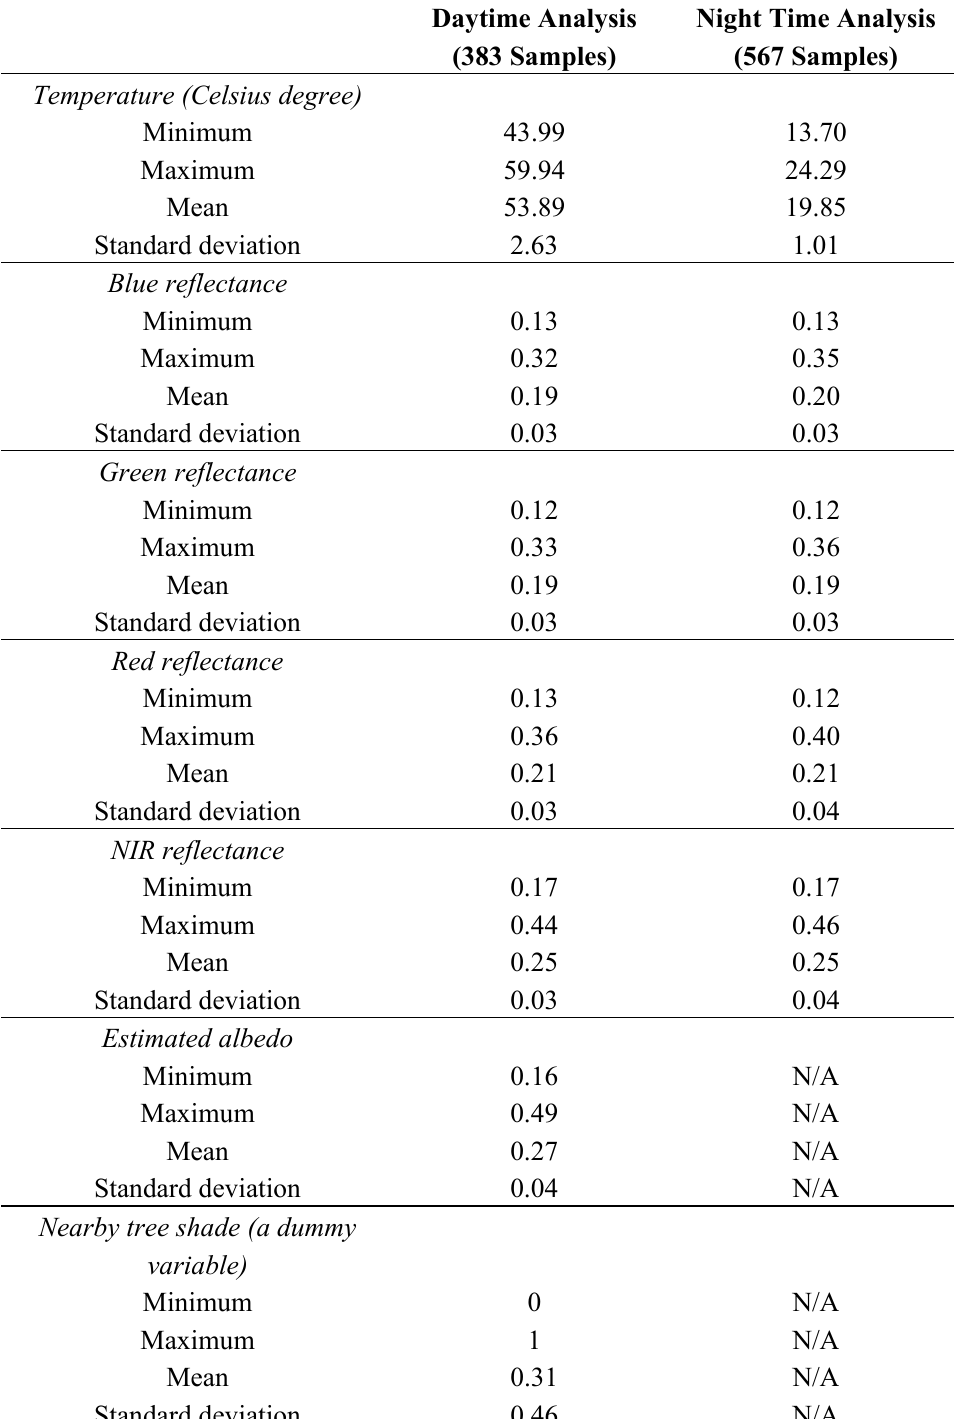
Table 3. Descriptive statistics of the selected dependent and independent